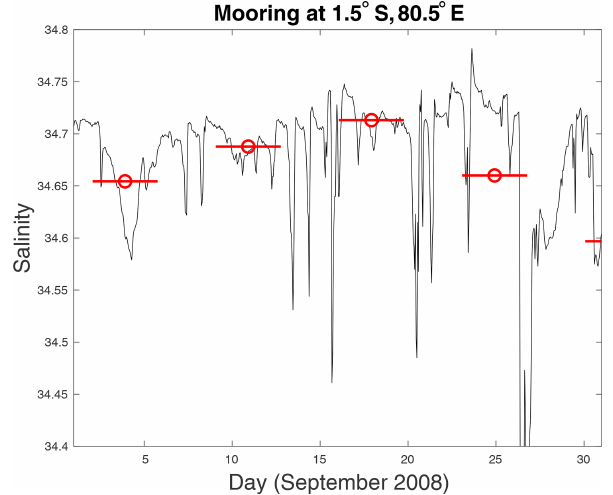
Figure 2. Sample salinity record from mooring at 1.5 ◦ S, 80.5 ◦ E for the month of September 2008. The weekly evaluation times are shown by red “O” symbols. The ensemble time period for this moor- ing was found to be ∼ 3 . 7d. These time periods surround the eval- uation times and are indicated by the red lines, which are 3.7d long from beginning to end. The red symbols are at the mean SSS value for each ensemble time